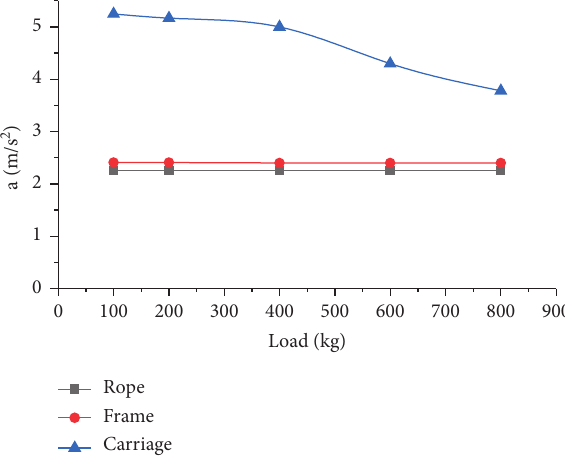
Figure 14: Deceleration peaks during the downward emergency